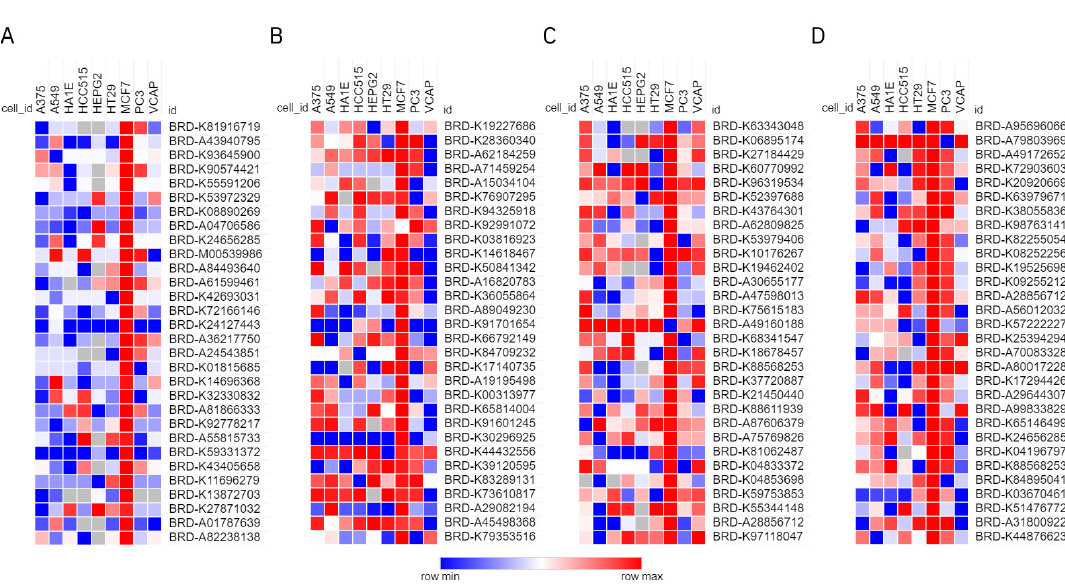
Figure 6. The heat map of connectivity scores for ( A ) Danshensu, ( B ) Tanshinone IIA, ( C ) Donepezil, and ( D ) Memantine.